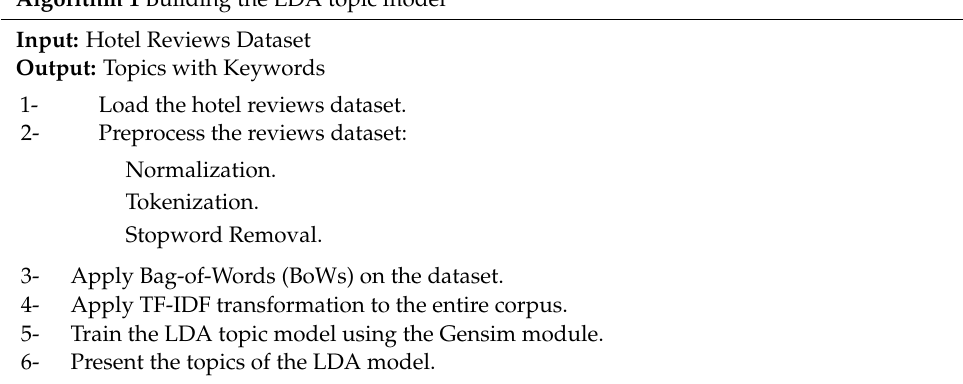
Algorithm 1 Building the LDA topic model